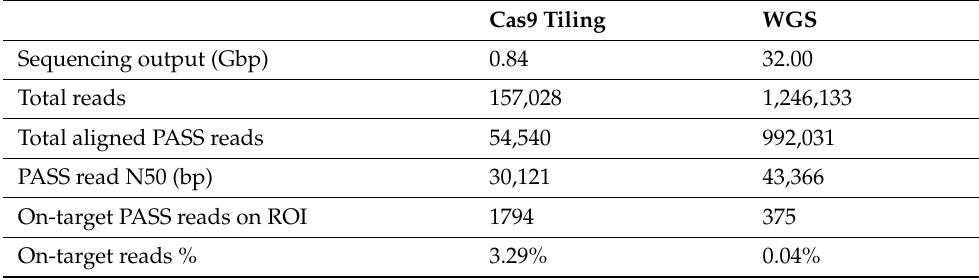
Table 2. ONT sequencing statistics, comparing Cas9 tiling and whole genome sequencing